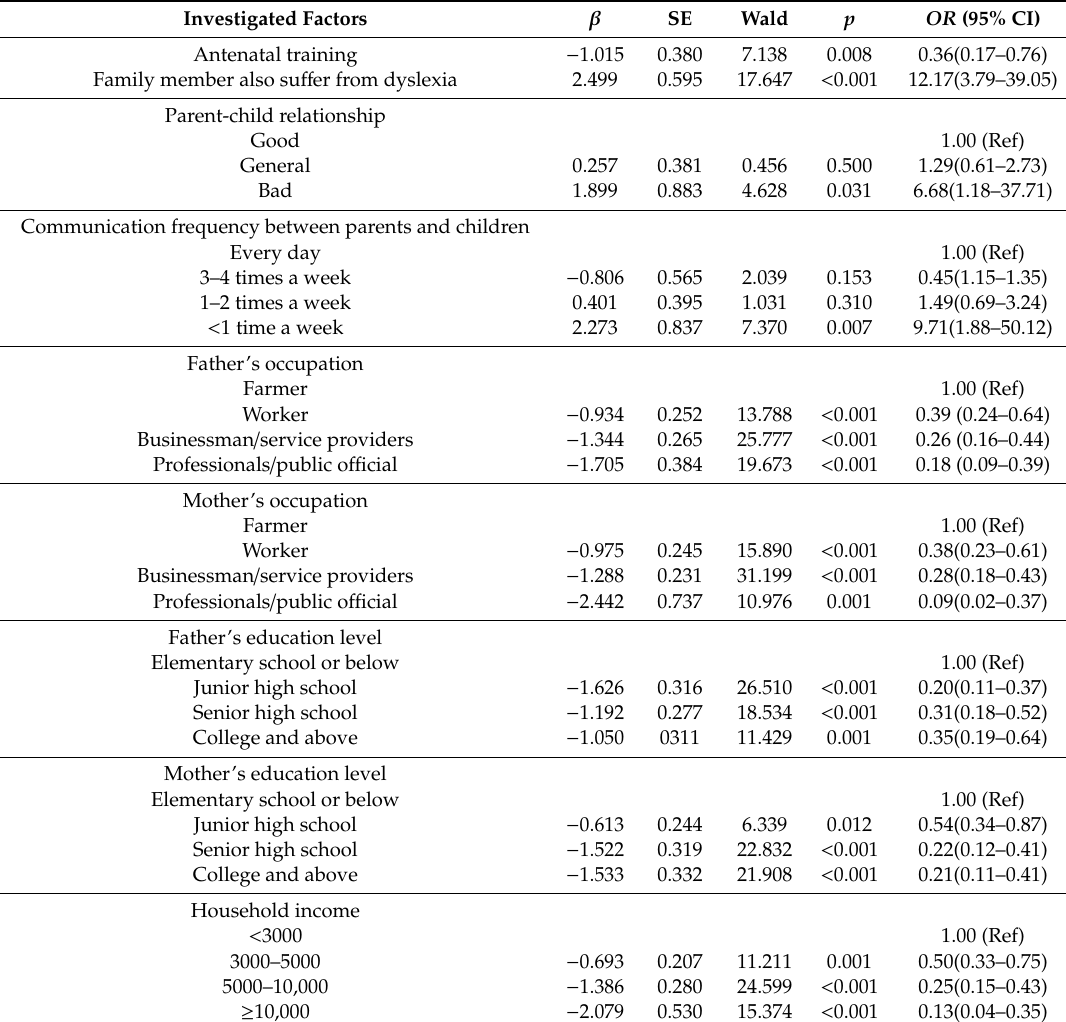
Table 2. Multiple logistic regression analysis of the family influencing factors associated with dyslexia in children ( n =